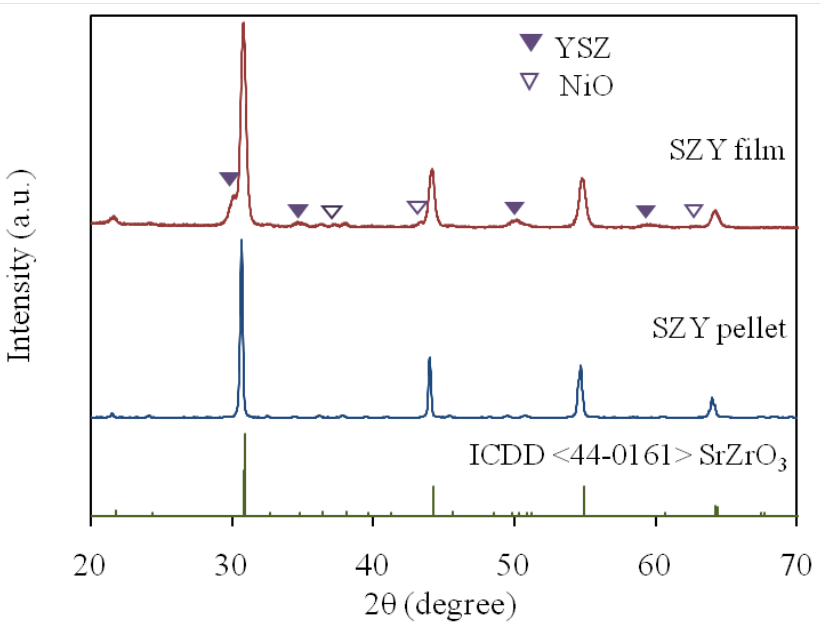
Figure 2. XRD patterns for the bulk Sr 0.98 Zr 0.95 Y 0.05 O 3−δ (SZY) sample and SZY film on NiO-yttria-stabilized zirconia (YSZ) substrate.